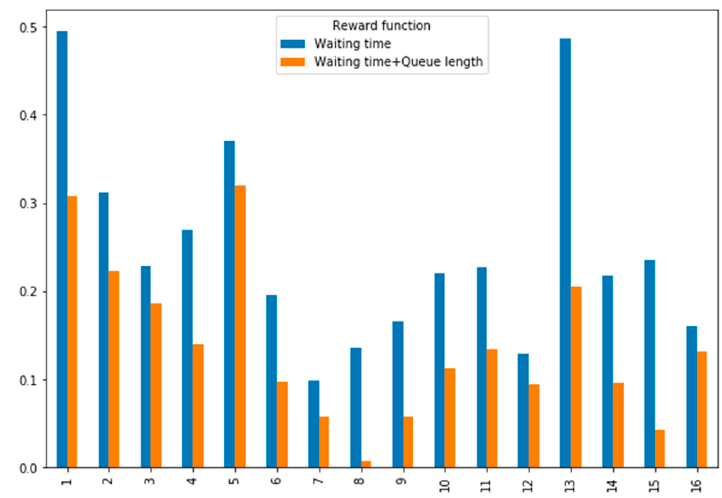
Figure 11. Performance comparison for reward function.